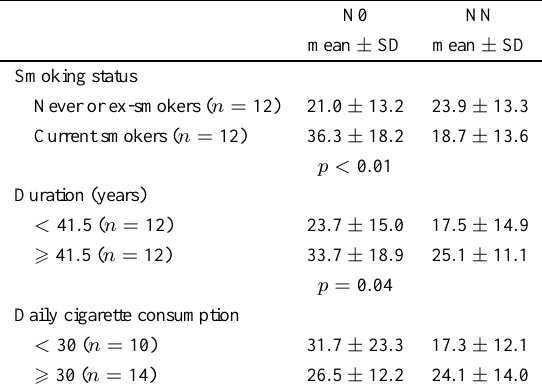
GPA N0 and NN variant frequencies according to smoking habits (VF (cid:2) 10 (cid:0) 6